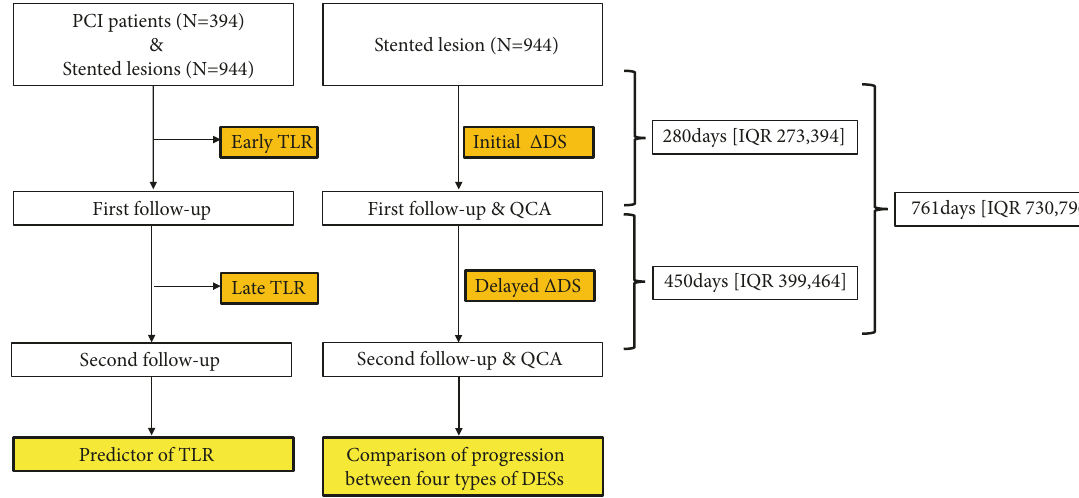
Figure 1: Flowchart of the study.